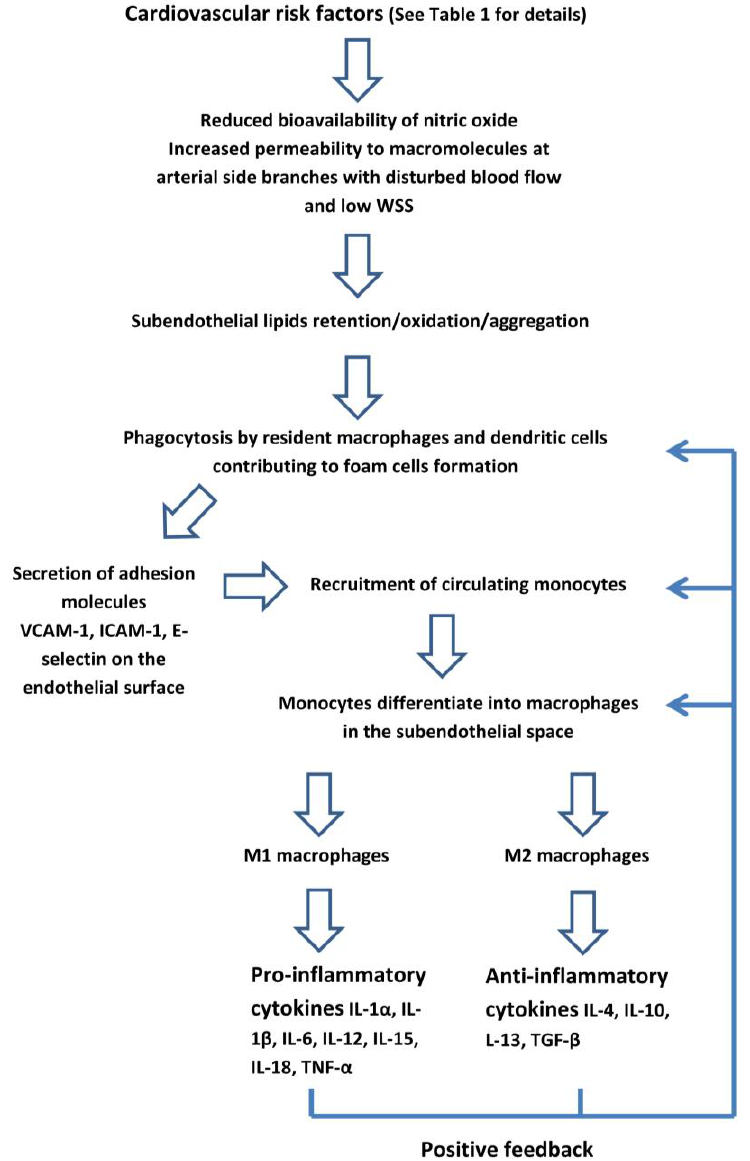
Figure 1. The early phase of atherosclerotic lesions starts with endothelial dysfunction which triggers a low-grade inflammatory response. WSS: wall shear stress. VCAM: vascular cell adhesion molecule. ICAM: intercellular adhesion molecule.